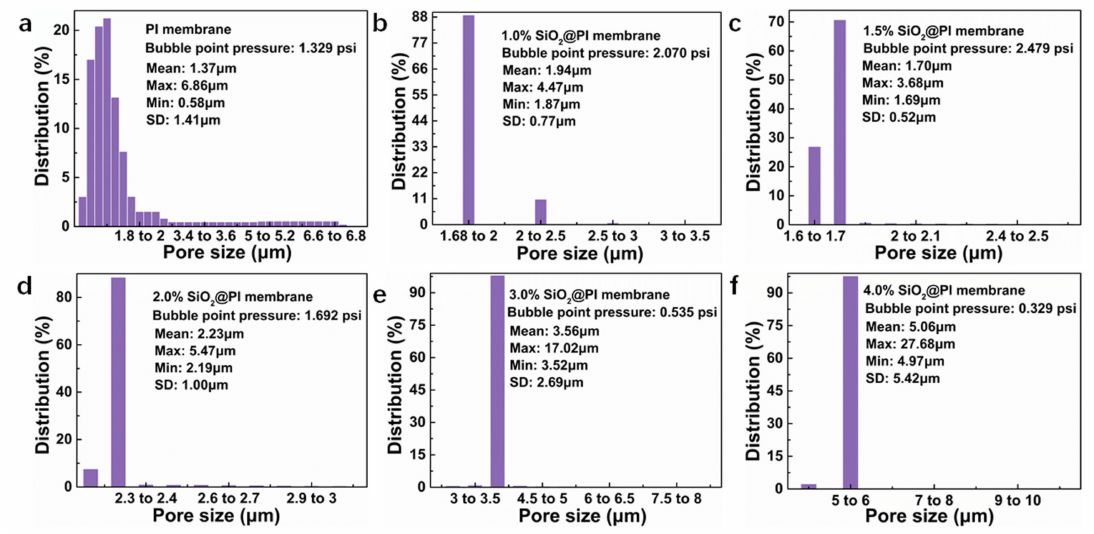
Figure 7. Pore sizes and their distributions of various SiO 2 @PI hybrid membranes. ( a ) PI, ( b ) 1.0% SiO 2 @PI, ( c ) 1.5% SiO 2 @PI, ( d ) 2.0% SiO 2 @PI, ( e ) 3.0% SiO 2 @PI, and ( f ) 4.0% SiO 2